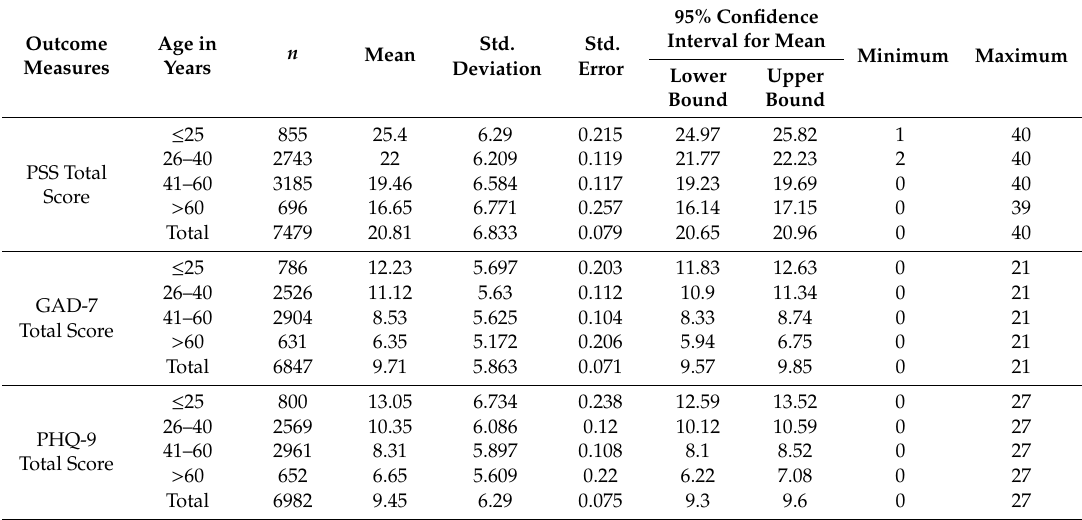
Table 3. Mean scores on the PSS, GAD-7 Scale and PHQ-9 Scale by age.